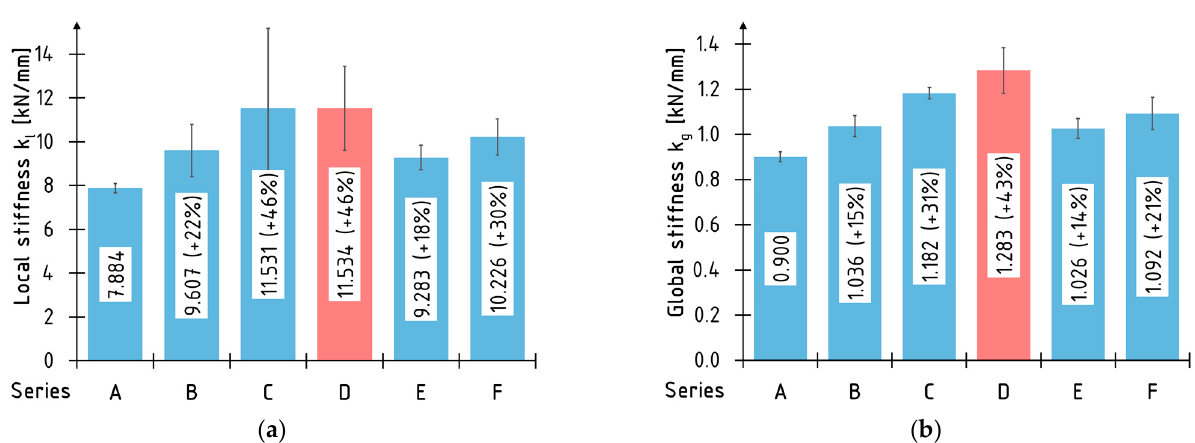
Figure 19. Average values of stiffness coefficients: ( a ) local k l ; ( b ) global k g .